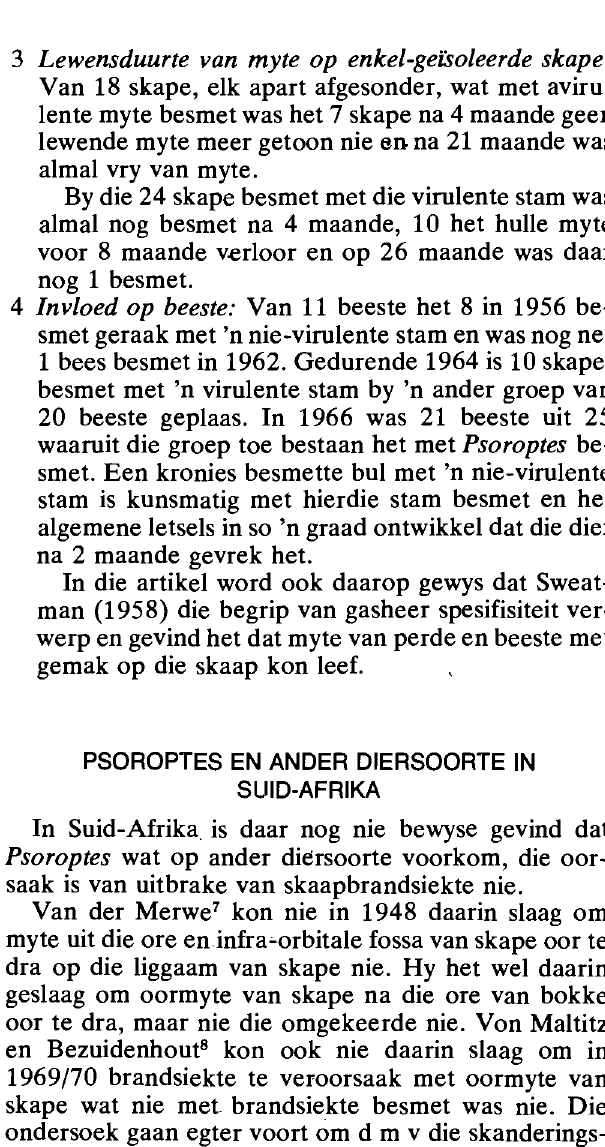
FIG.3. SKAAPBRANDSIEKTE-UITBREKE PER